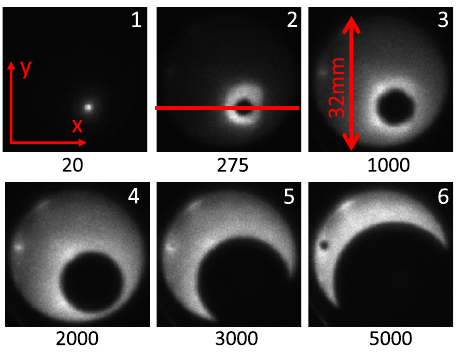
FIG. 14. Images of the focused beam with the DMD set to concentric circular mask of successively larger radii; number below image denotes the number of frame integrations on the ICCD